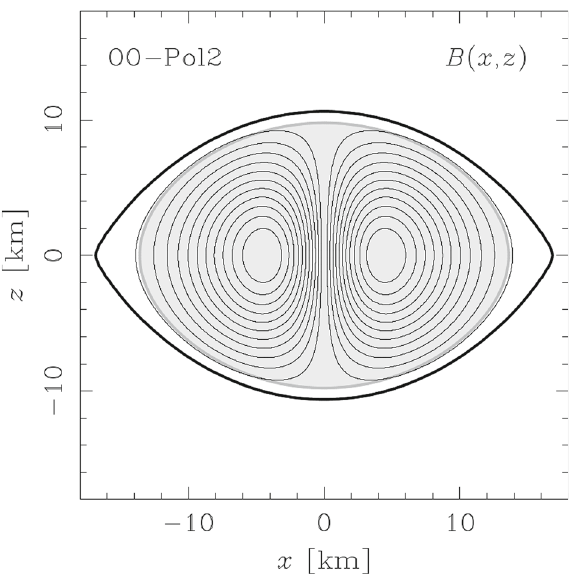
Fig. 5 Isocontours of magnetic field strength in the meridional plane, for a rapidly rotating model with a purely toroidal magnetic field. (Image from Frieben and Rezzolla 2012, copyright by the authors)